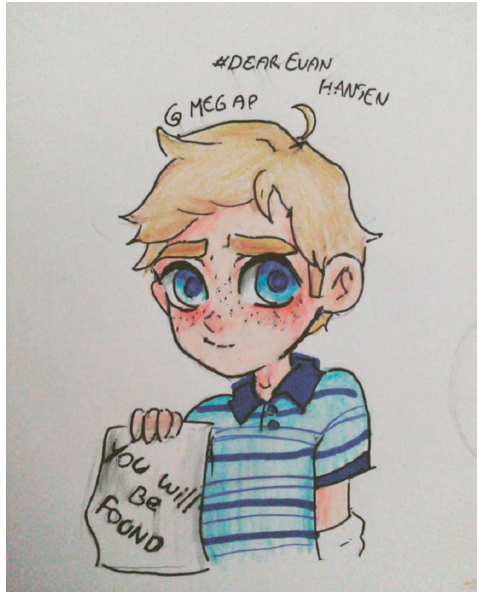
Figure 2. A sketch of Evan Hansen, again accompanied by the key phrase ‘You will be Found’. Used with permission from @_toxic.chemical_ on Instagram (2020).